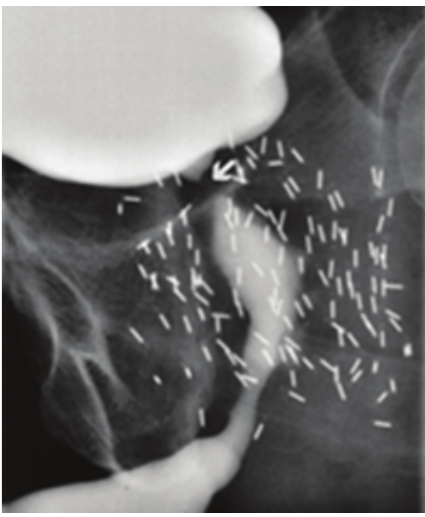
Figure 1: Bulbar and bladder neck stricture from combined EBRT and brachytherapy. Credit to R. Santucci